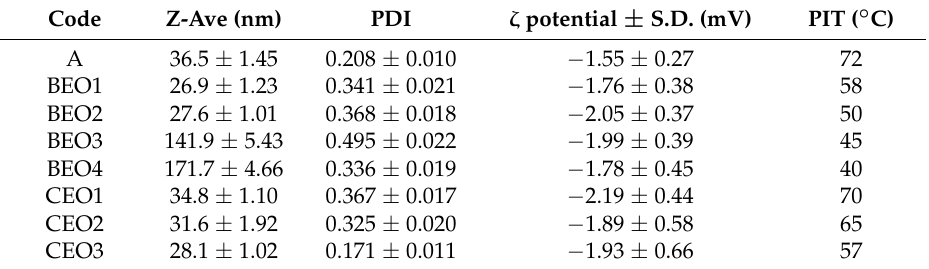
Table 3. Mean size (Z-Ave ± standard deviation (S.D.)), polydispersity index (PDI ± S.D.), ζ potential ( ± S.D.) and phase inversion temperature (PIT) of unloaded and rosemary oil-loaded lipid